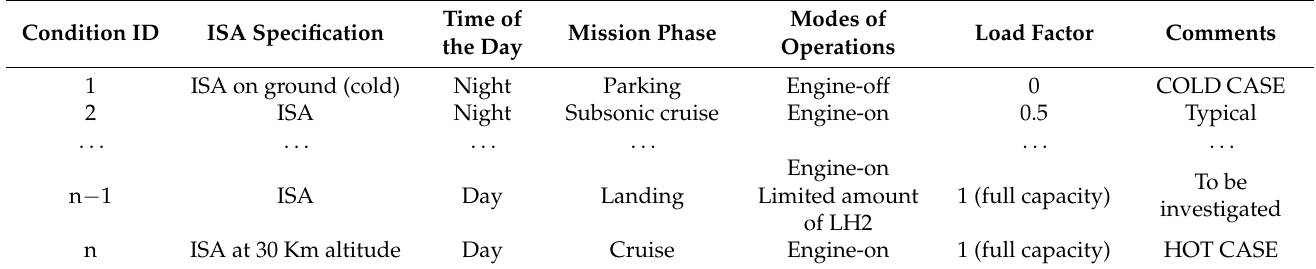
Table 2. Cold and hot cases for hypersonic vehicles (nominal